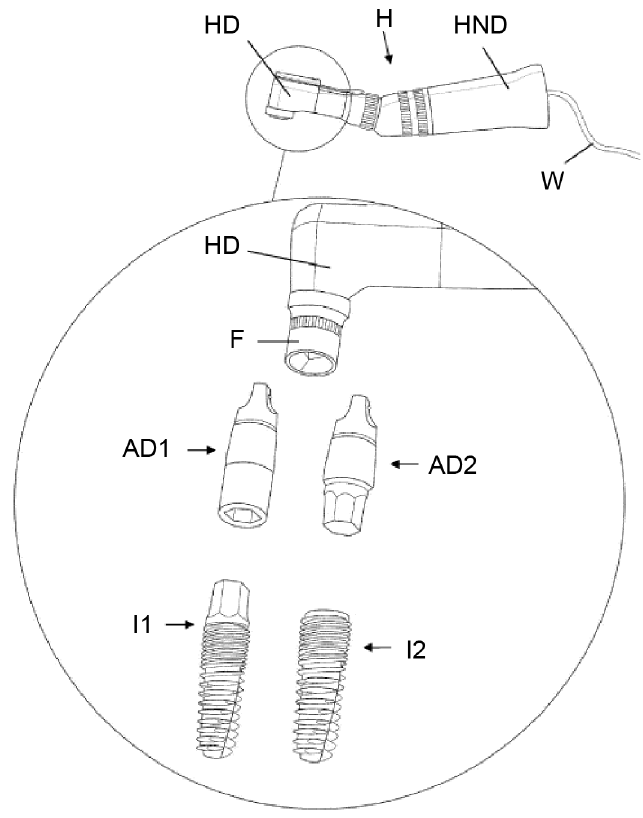
Figure 6. An ultrasound vibration actuator in a handpiece (HND) with a handpiece head (HD) and holding device (F) are shown. AD1/2 ensures a rigid and firm connection between the handpiece